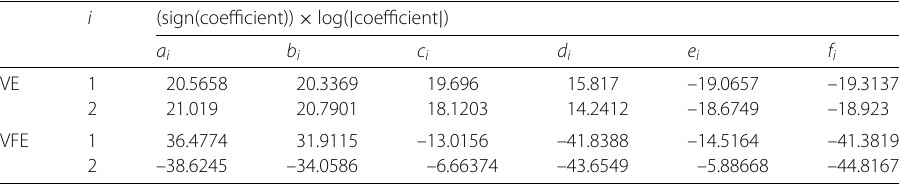
Table 2 Optimized coefficients of Padé approximate